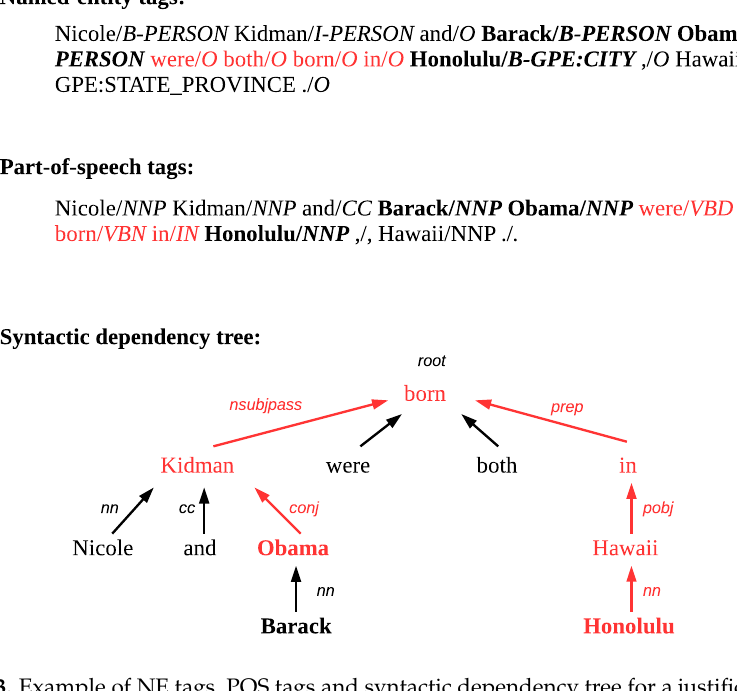
Figure 3. Example of NE tags, POS tags and syntactic dependency tree for a justification